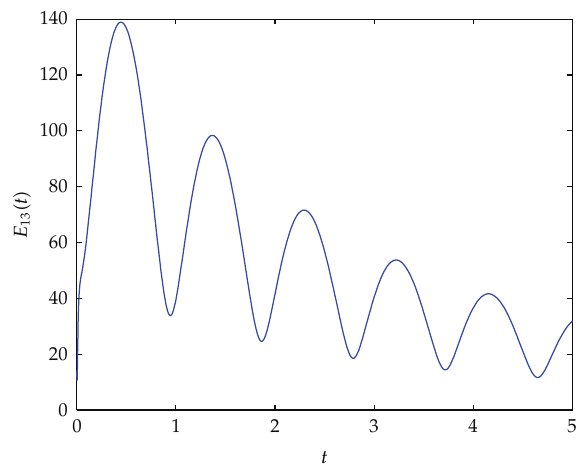
Figure 7: Time evolution of the synchronization error E 13 (cid:6) t (cid:7)